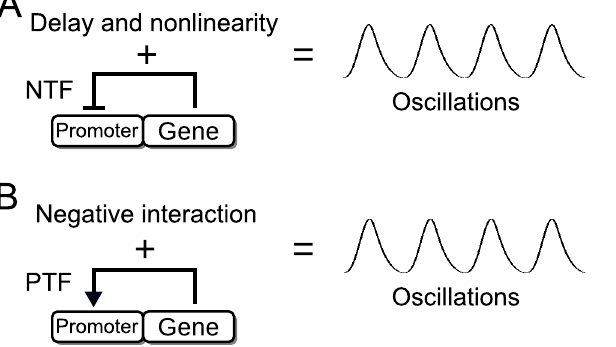
Figure 1. Diagram of one-gene oscillators with negative and positive transcriptional feedbacks. A . Negative transcriptional feedback (NTF) created by a protein that represses the expression of its own gene. This NTF needs time delay and sufficiently strong nonlinearity in the feedback signal transmission in order to produce reliable oscillations. The time delay is created by intermediate reactions, such as the transcription and translation, reversibly phosphorylations or proteins shuttling between the nucleus and the cytoplasm. The nonlinearity can be created by reactions, such as protein cooperativity in the gene repression or formation of protein multimers. B . Positive transcriptional feedback (PTF) created by a protein that activates the expression of its own gene. This PTF needs a negative interaction in the feedback signal transmission in order to produce reliables oscillations. The negative interaction can be a degradation, sequestration, or inhibition carried out by a repressor molecule.